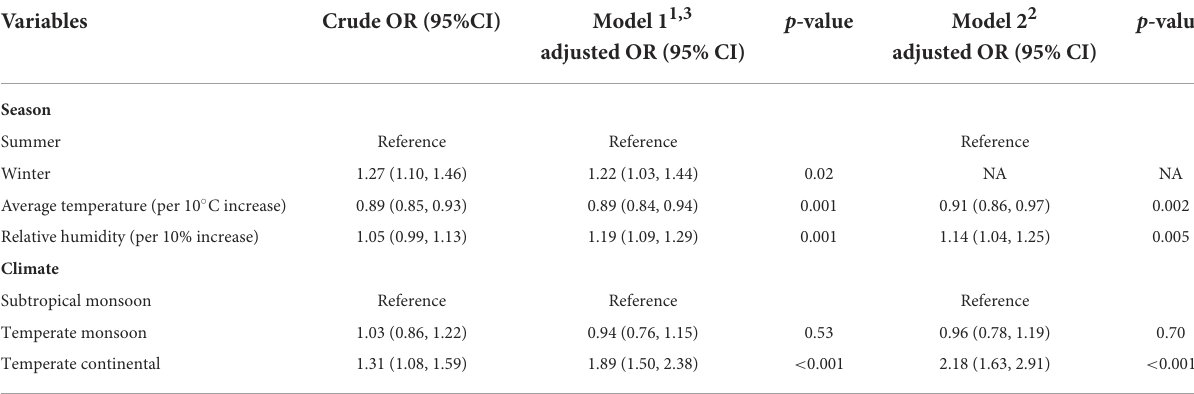
TABLE 3 Multivariable logistic regression model analysis of environmental factors associated with in-hospital mortality of patients with AKI. Variables